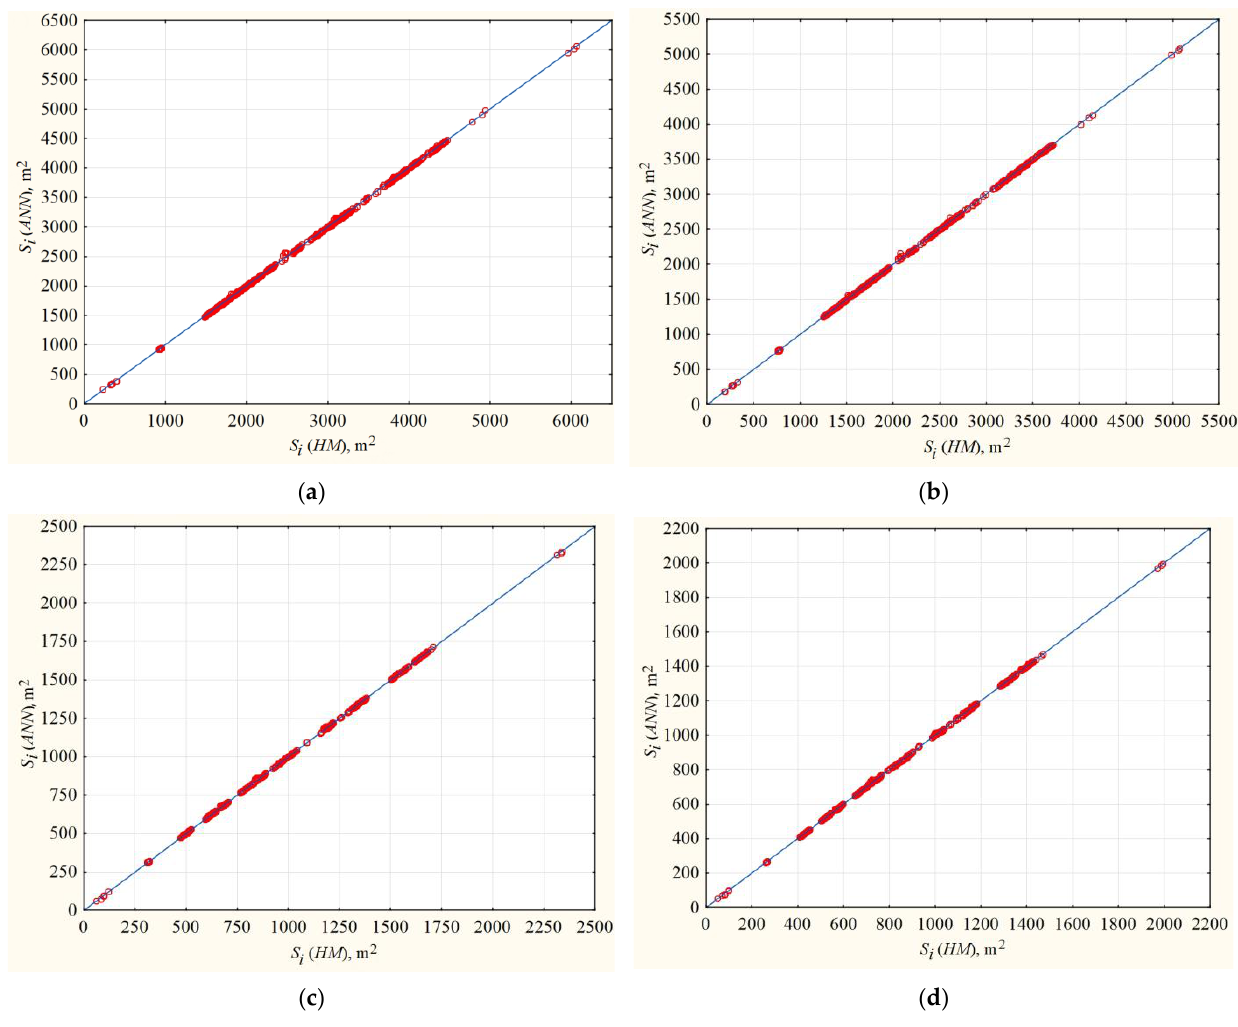
Figure 13. Comparison of the required area of the stormwater infiltration facility ( S i ) generated from the artificial neural network (ANN) and obtained from hydrodynamic simulations (HM): ( a ) infiltration basin, fully water saturated; ( b ) infiltration basin, completely drained; ( c ) infiltration tank, fully water saturated; ( d ) infiltration tank, completely drained. Table 3. Summary of the results of the global sensitivity analysis (ANNs — artificial neural networks; MLP — multilayer perception network, other designations as in Figure 2).